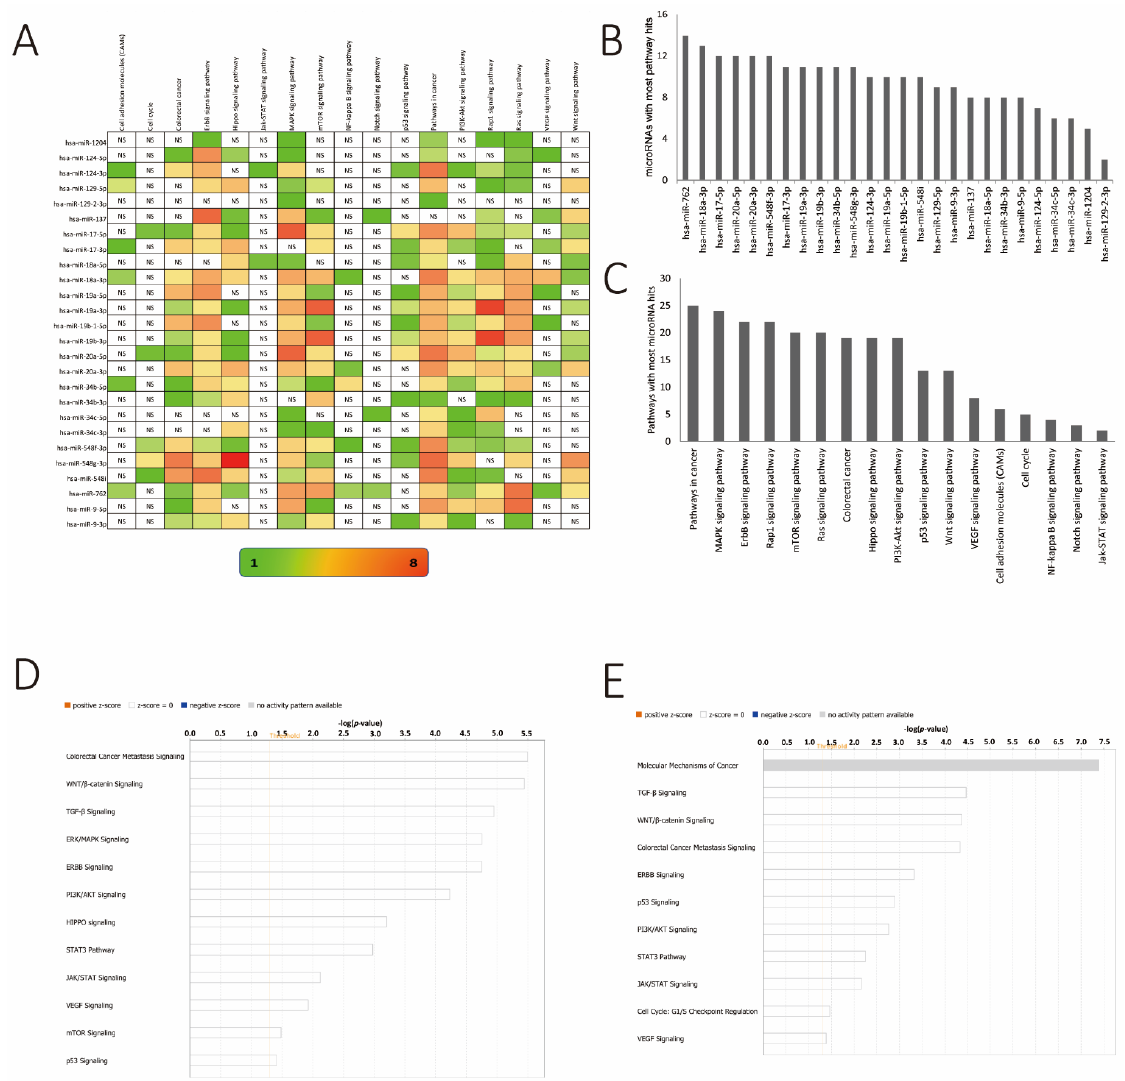
Figure 5. KEGG pathway enrichment analysis by using DAVID Ease. ( A ) Number of genes related to the enriched KEGG pathway. The color of the bar corresponds to log10 ( p -value). ( B ) Bar diagram showcasing miRs regulating the highest number of canonical pathways in descending order. ( C ) Bar diagram showcasing canonical pathways regulated by the largest number of miRs from the differential methylation list (see Figure 4) in descending order. ( D ) Ingenuity pathway analysis of targets of hypermethylated miR genes. The threshold line is equivalent to a –log p value of 0.05. ( E ) Ingenuity pathway analysis of targets of hypomethylated miR genes. The threshold line is equivalent to a –log p value of 0.05.